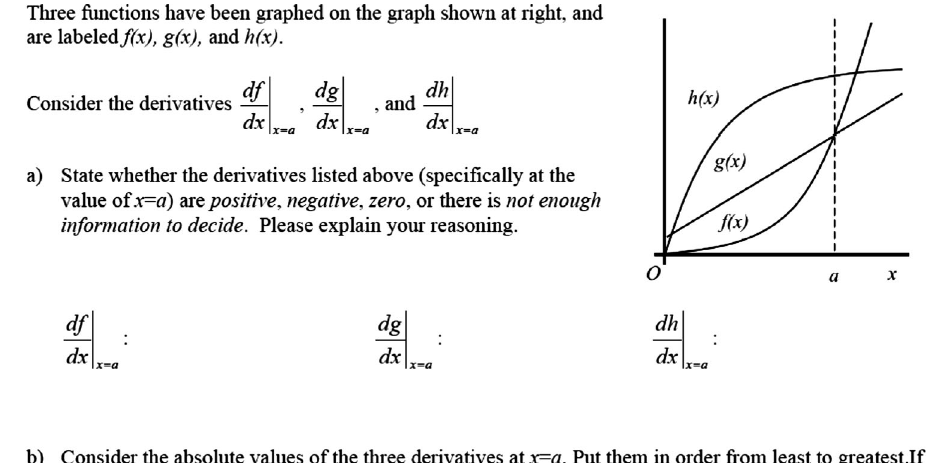
FIG. 5. Modified Derivative Sign and Ranking Task, to have more explicit wording and a greater slope for h ð x Þ at x ¼ a